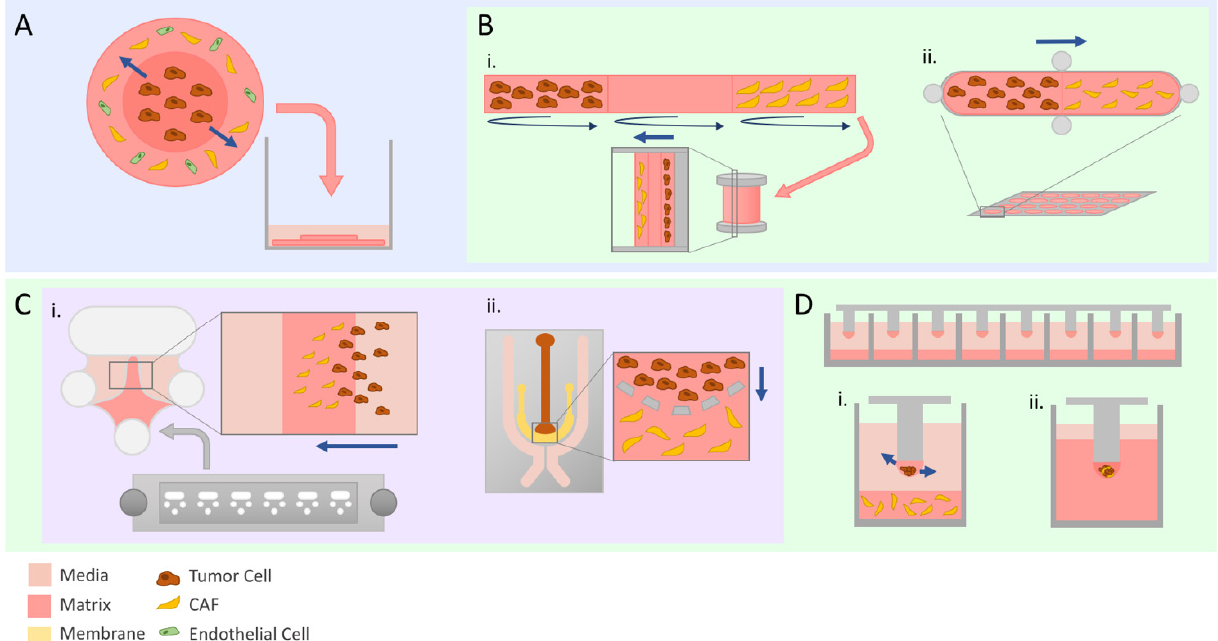
Figure 2. Advanced modeling of tumor invasion. Straight navy arrows indicate direction of tumor cell invasion. Schematics illustrate set-ups used by discussed studies. ( A ) The tumoroid model is composed of two matrix discs representing tumor and stroma synthesized separately and then assembled into one entity before being submerged in media. ( B ) Bioengineered models with customizable compartments. TRACER (i) is a 3D model where cells are seeded on marked sections of a biocomposite strip before being rolled to replicate physiologically relevant hypoxia and nutrient gradients. GLAnCE (ii) has two compartments and is suited specifically for looking at the interface between the two. ( C ) Microfabricated chips are a cost-effective way to set up invasion assays due to the small amounts of material required. The Iuvo Invasion Assay slide (i) contains two side ports and a center port where matrix can be deposited. Microfluidics chips (ii) can be particularly useful to evaluate the effect of chemokine or cytokine gradients due to the design of the media channels on the outer portion of the chip surrounding the cell-containing inner channels. ( D ) Micropillar chips allow for scaling up of invasion experiments. Tumor cells and CAFs can either be seeded separately to evaluate paracrine interactions (i) or a co-culture spheroid can be embedded in the droplet (ii) prior to being fully embedded.